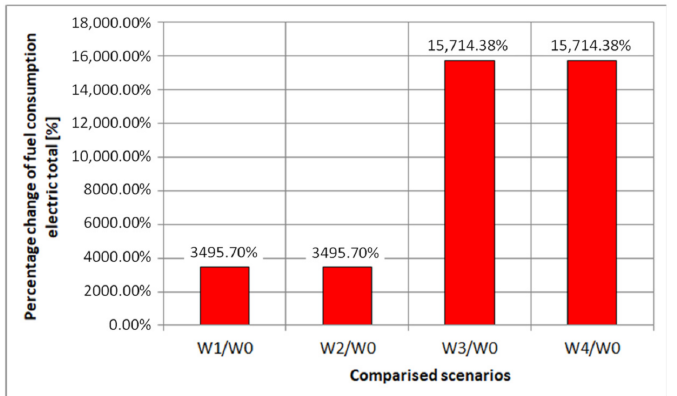
Figure 26. Values of the ratio between W0 and scenarios W1–W4 for fuel consumption electric [MJ]—analysis for the city